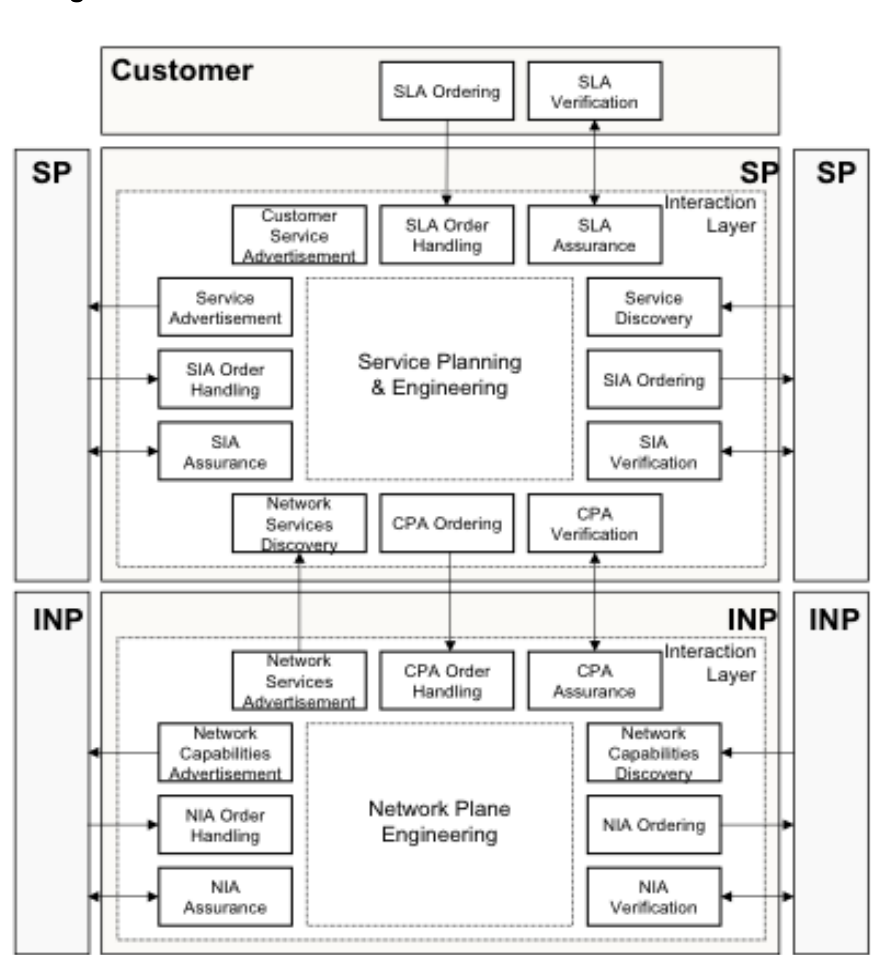
Figure 3. AGAVE‟s functional architecture. Extracted from